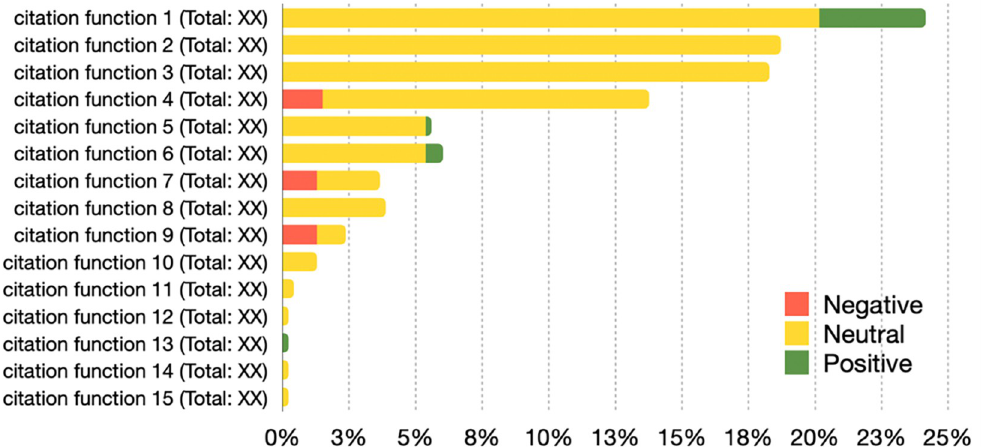
Fig 6. A horizontal bar chart representing the distribution of the in-text citations according to their citation functions. The graphic highlights the negative/neutral/positive percentages of in-text citations and mentions, between brackets, the total number on in-text citations annotated with such a citation function. The length (total percentage value) of the bars is in relation to the total number of in-text citation for the period in the PERIOD-SET shown by the graph.